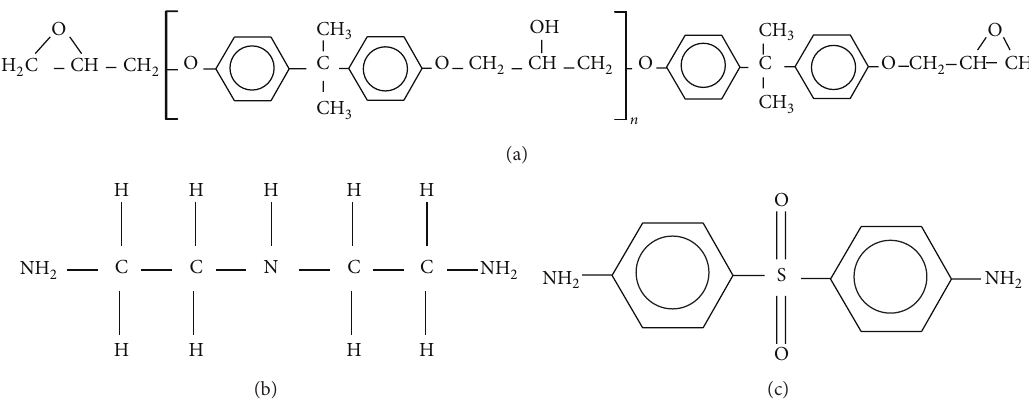
Figure 1: Chemical structures of epoxy resins. (a) DGEBA, (b) DETA, and (c) DDS.